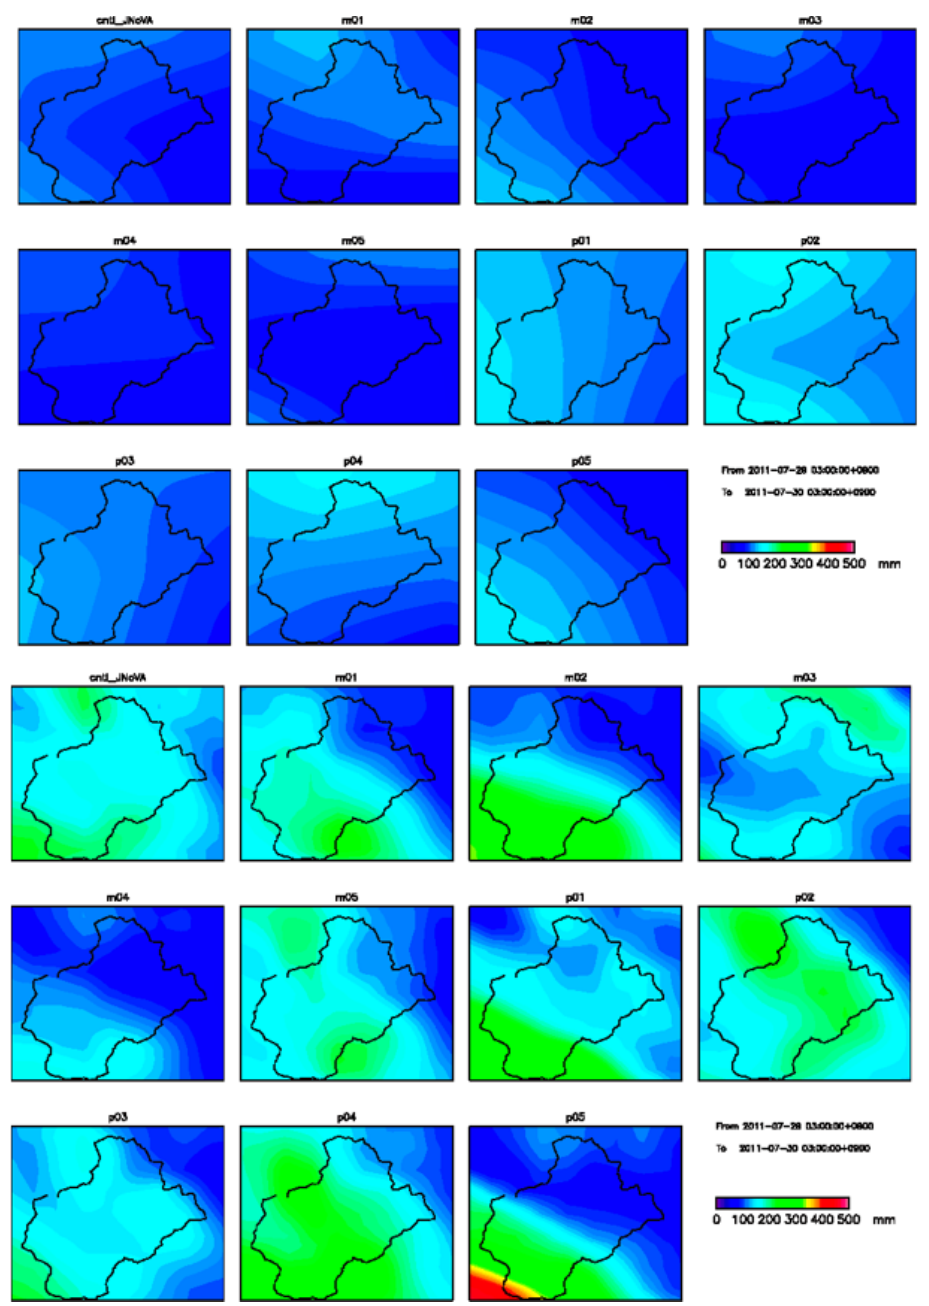
Figure 13. Spatial distributions of cumulative ensemble rainfalls (upper: 10km resolution; lower: 2km resolution). Table 2. Cumulative rainfall of 2 and 10km resolution ensemble rainfall